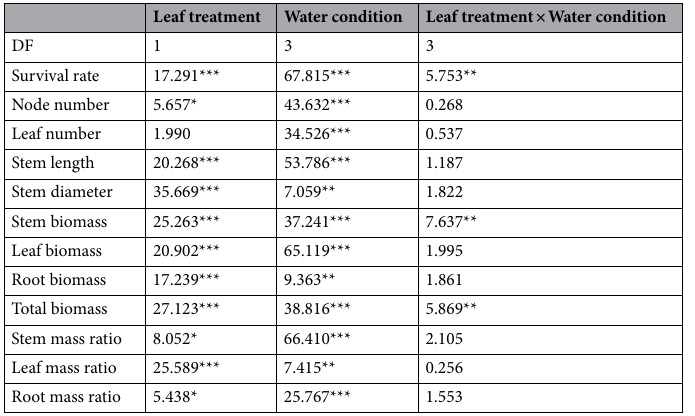
Table 1. Two-way ANOVA for the survival rate, morphological traits, biomass, and biomass allocation of A. philoxeroides in Exp. 1. The degree of freedom (DF), F values and significance levels (*** P < 0.001, ** P < 0.01, * P < 0.05) are